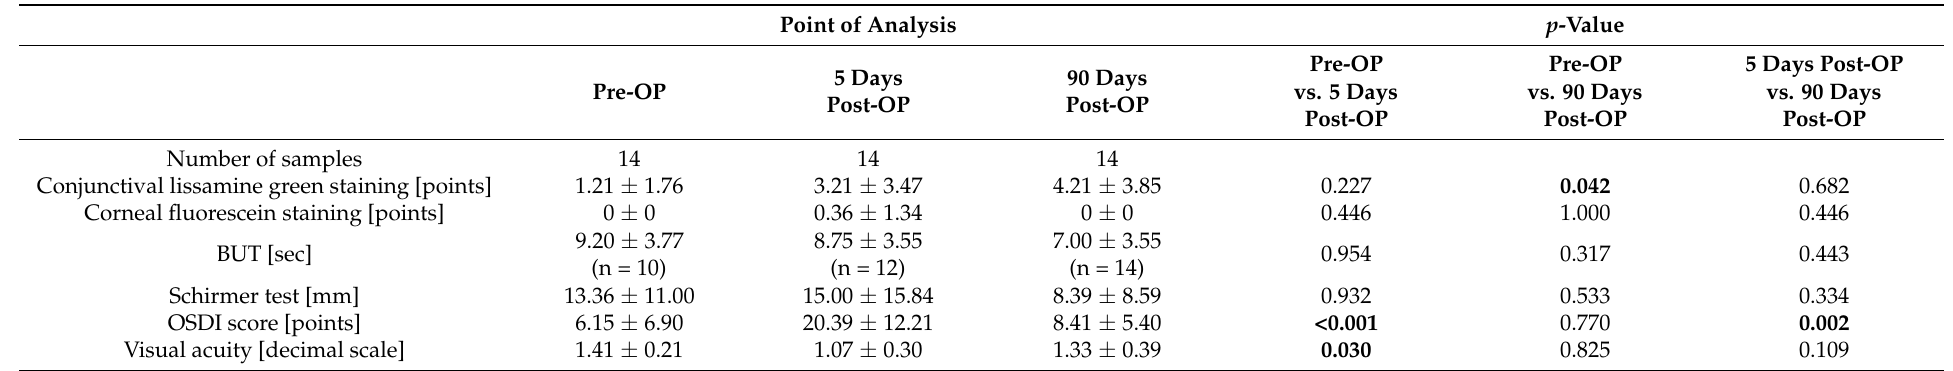
Table 2. Classical dry eye examination (mean ± SD) before as well as 5 and 90 days after Femto-LASIK. Visual acuity pre-OP was best corrected distance vision and uncorrected vision post-OP. Significant p -values are in bold. Abbreviations: BUT = tear break-up time; OSDI = ocular surface disease index.